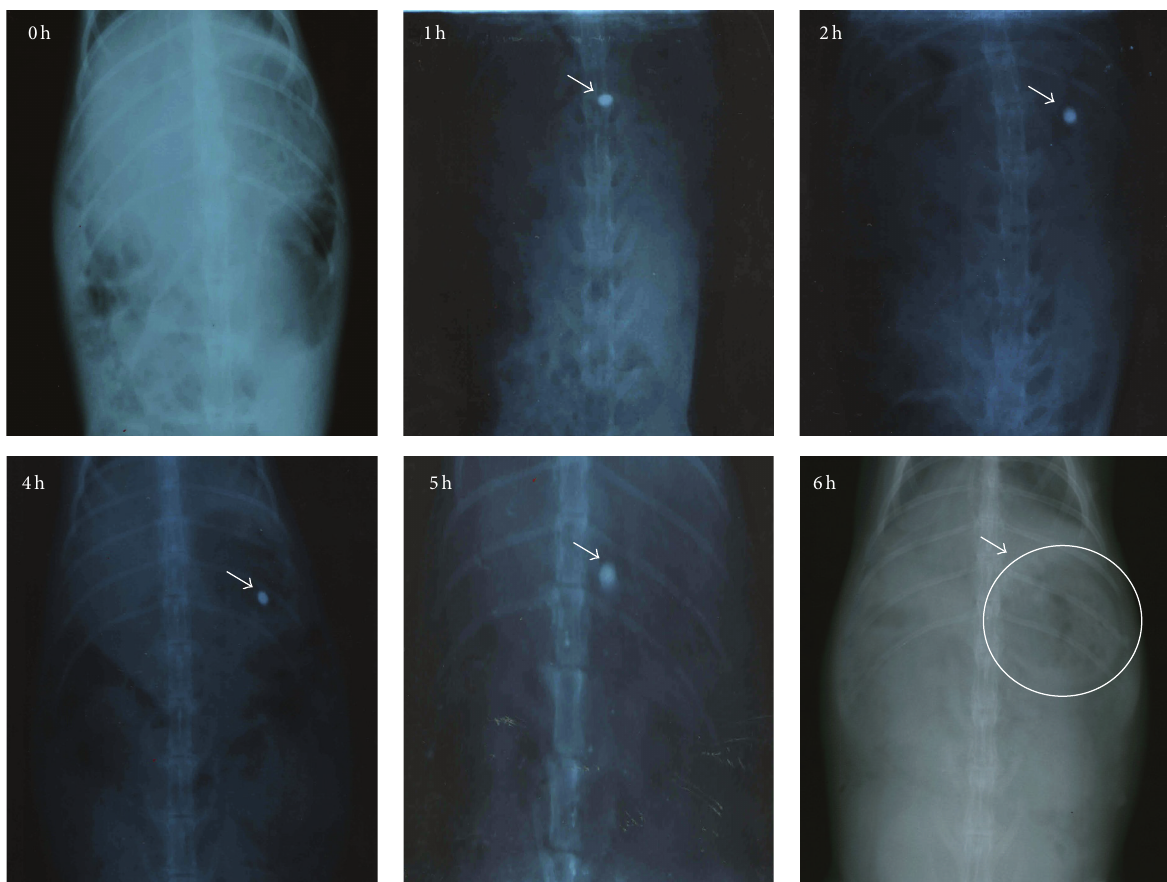
Figure 8: X-ray radiograms showing the presence of floating tablet in rabbit gastric region.